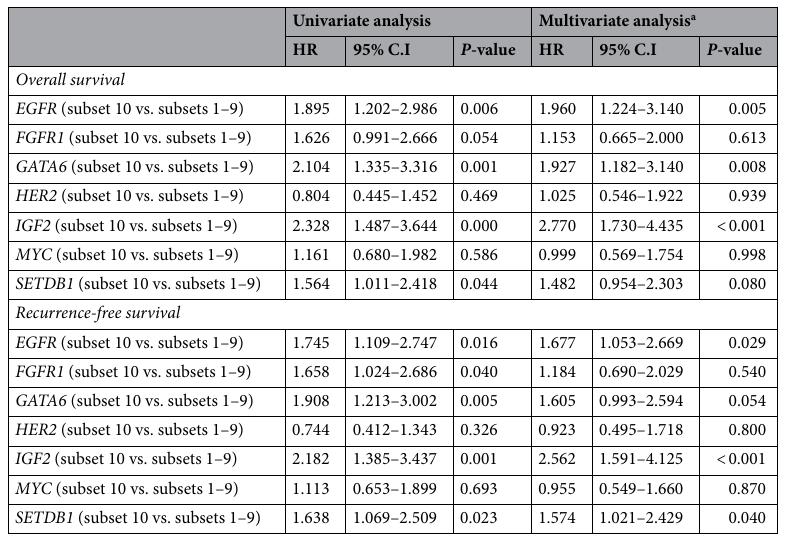
Table 1. Univariate and multivariate Cox regression analyses for overall survival and recurrence-free survival. a Cox proportional hazards regression model, adjusted for tumor subsite, Lauren histology, lymphatic emboli, venous invasion, perineural invasion, T category, N category, and M